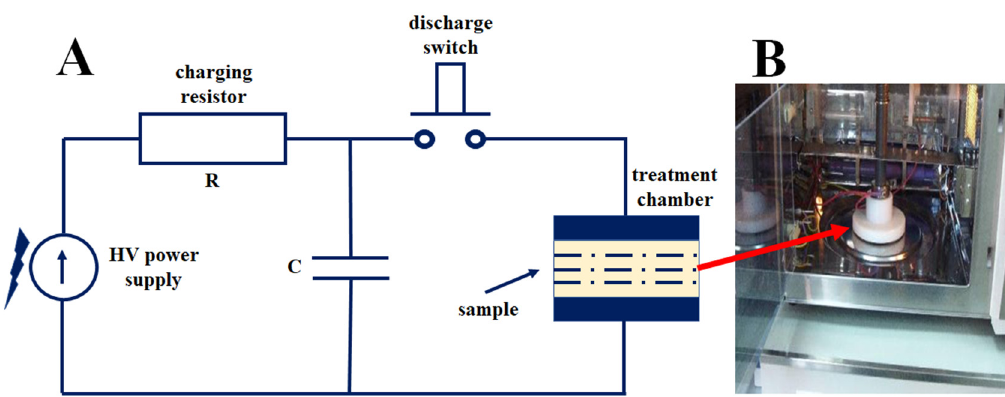
Figure 3. Impulse reactor: ( A ) schematic; ( B ) inside the reactor.